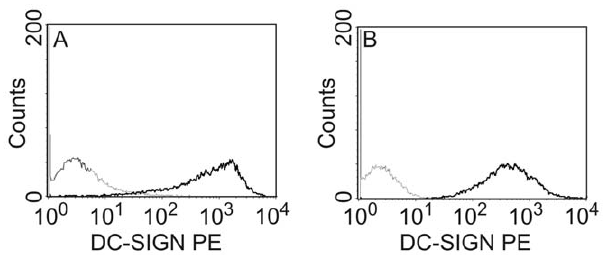
Figure 2. DC-SIGN expression in stably transfected MDCK DC- SIGN and Vero DC-SIGN cells. MDCK cells (A) and Vero cells (B) without (dotted line) and transfected with the gene encoding DC-SIGN (solid line) were analyzed for DC-SIGN expression after staining with a PE-labeled antibody to DC-SIGN and flow cytometry.